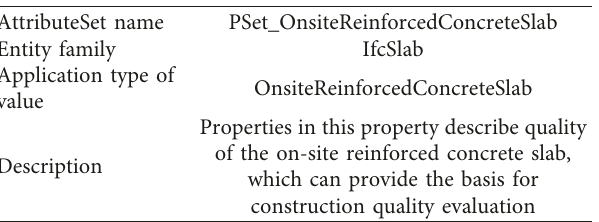
Table 6: The definition of IfcPropertySet of cast-in-place rein- forced concrete slab.